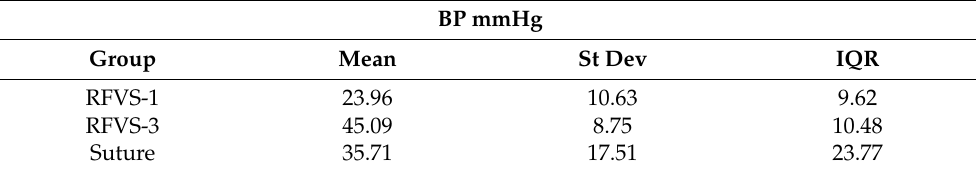
Table 2. BP test in study arm 2.